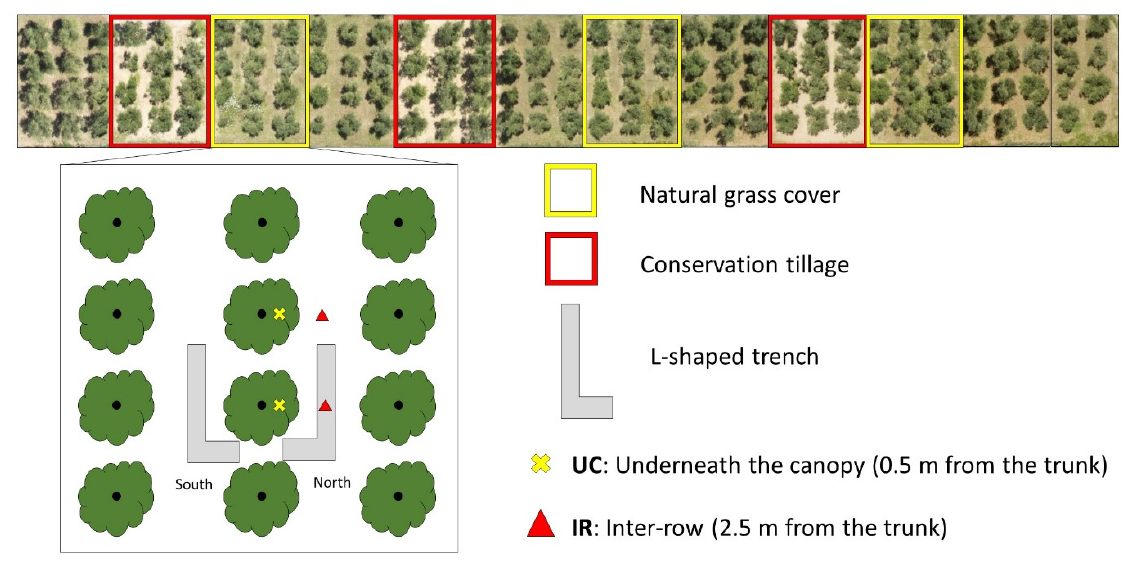
Figure 1. Experimental plots managed by natural grass cover (NC) or conservation tillage (CT). Soil cores were sampled under the canopy (UC) and in the inter-rows (IR).